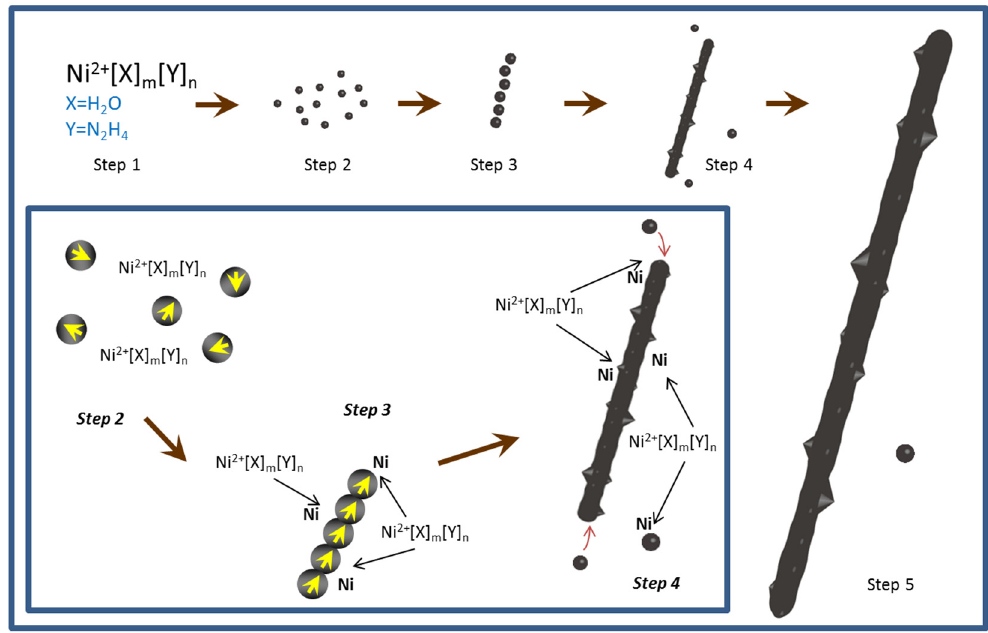
Figure 6. The illustration of NiNW growth mechanism. The inset is the detailed illustration of Step 2 to 4.